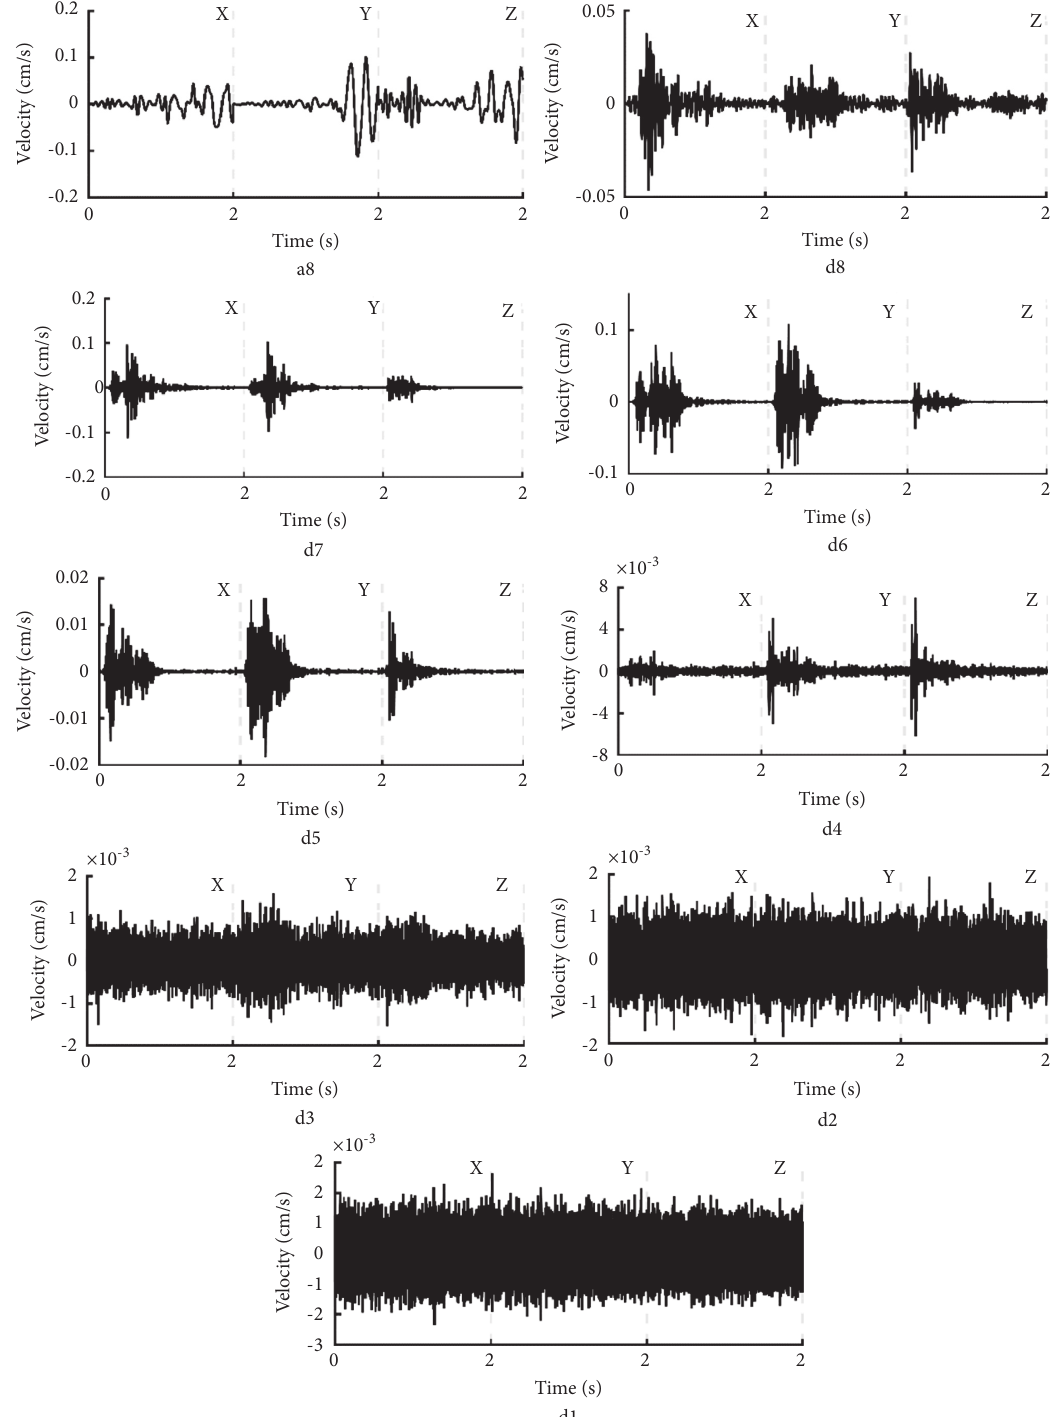
Figure 10: Stratified reconstruction of signals by wavelet